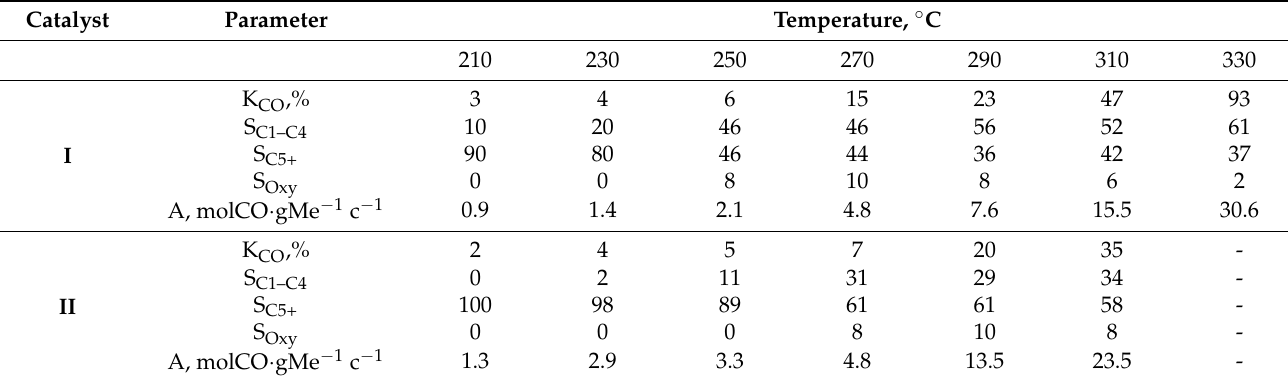
Table 4. The main FTS parameters in presence of I and II